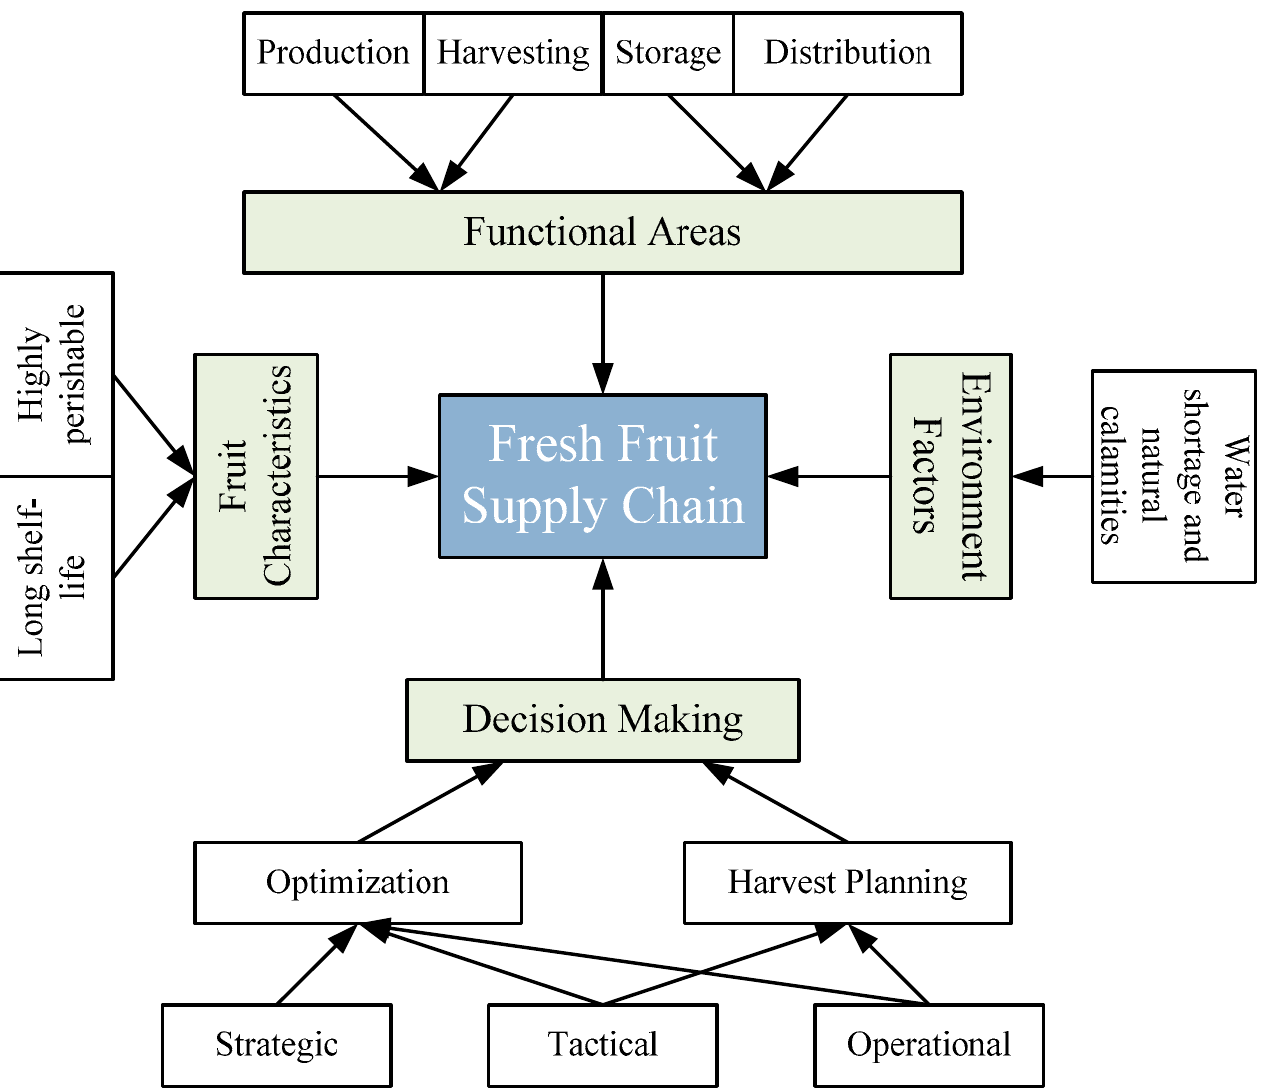
Figure 1. Constraints, challenges and influencing elements on the fresh fruit supply chain.